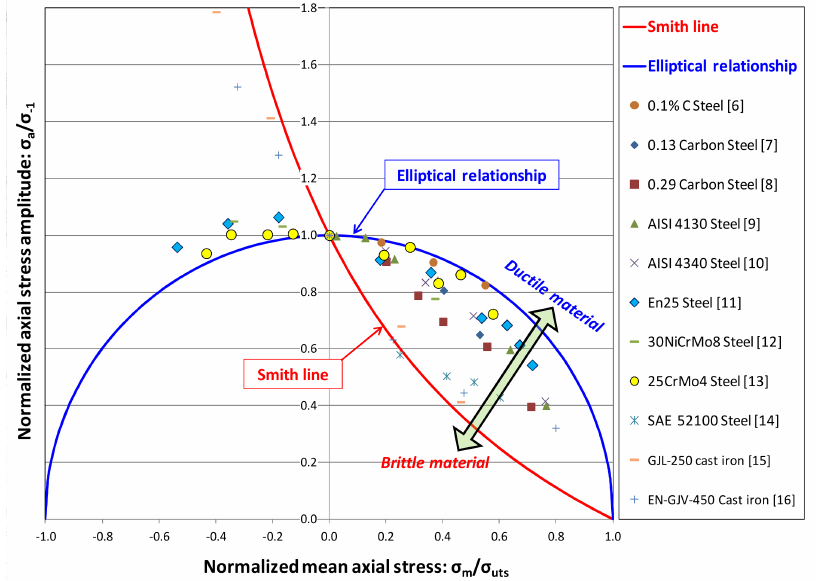
Figure 1. Normalized Haigh diagram showing the experimental results on 11 ferritic materials [6–16] together with the Smith line for brittle metals and the Elliptical relationship for ductile